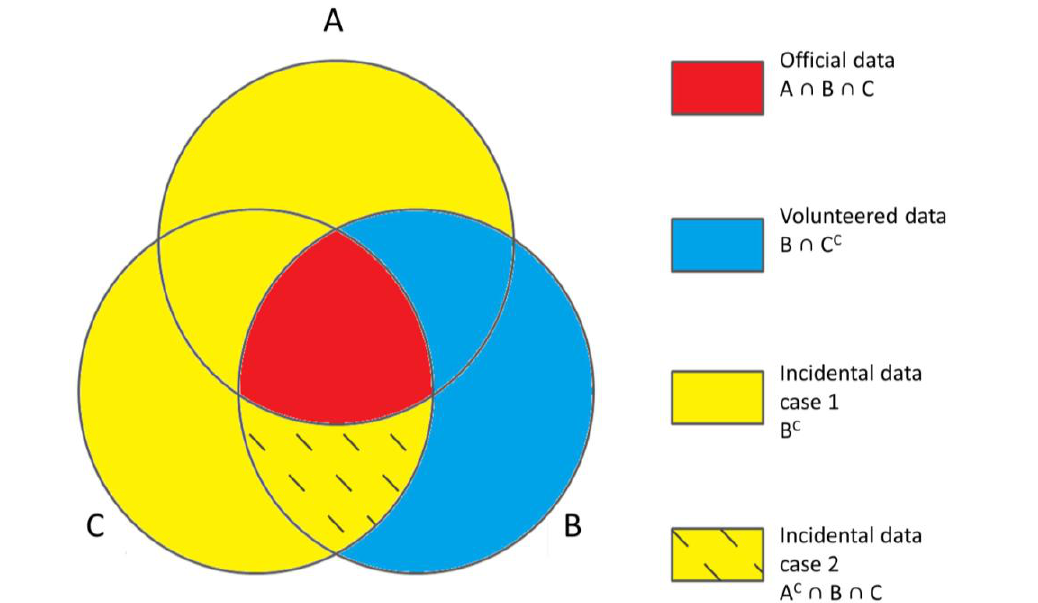
Figure 1. Representation of official, volunteered and incidental data according to Set